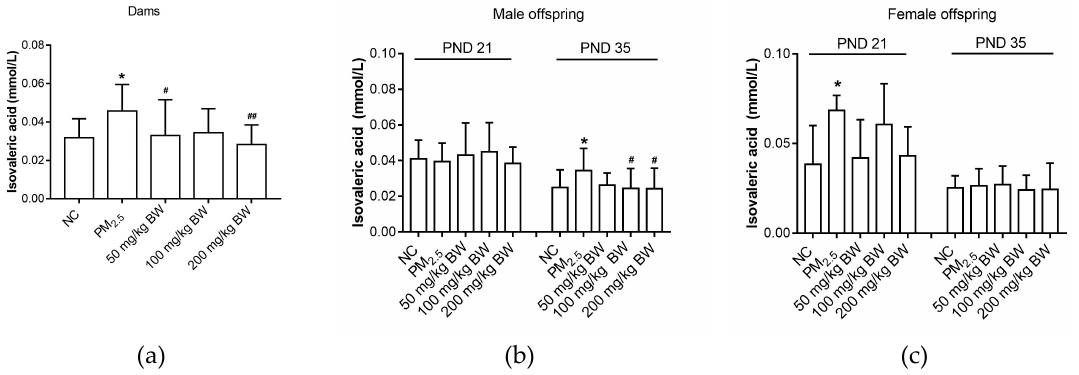
Figure 7. Isovaleric acid concentrations of dams and offspring. (a) Isovaleric acid of dams on PND 21. (b) Isovaleric acid of male offspring on PND 21 and PND 35. (c) Isovaleric acid of female offspring on PND 21 and PND 35. The data was expressed as mean ± SD of each group. Compared with the NC group, * indicates p < 0.05. Compared with the PM 2.5 group, # indicates p < 0.05, ## indicates p < 0.01.